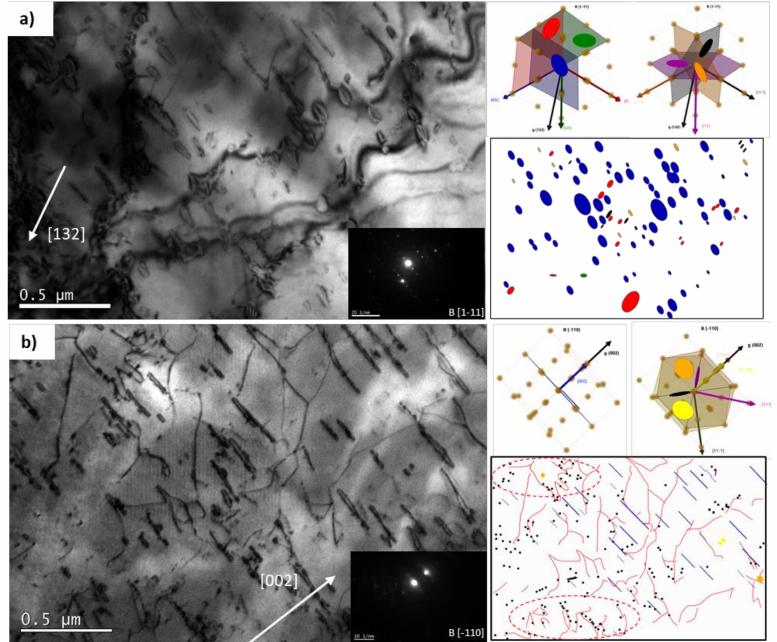
Figure 18. TEM micrographs of EFDA pure-iron thin film irradiated with 20 MeV at 300 ◦ C up to 4.25 × 10 15 ions/cm 2 near the [111] and [110] zone axis with two beam diffraction contrast condition along ( a ) [132] and ( b )